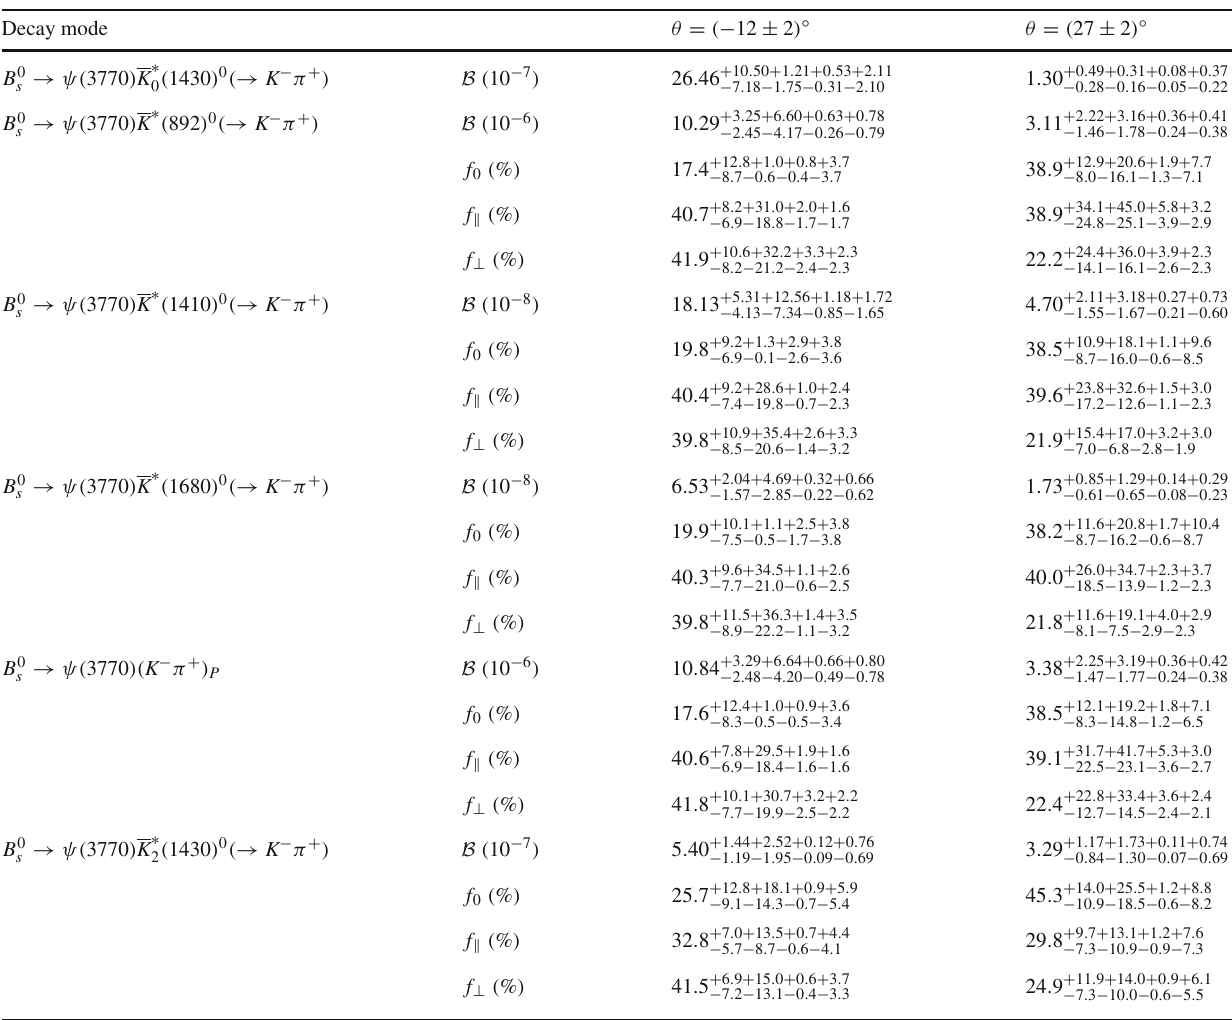
lated using the pQCD factorization approach. The first three uncertain- ties are derived from the uncertainties in the previous tables, whereas the last one is derived from the mixing angle